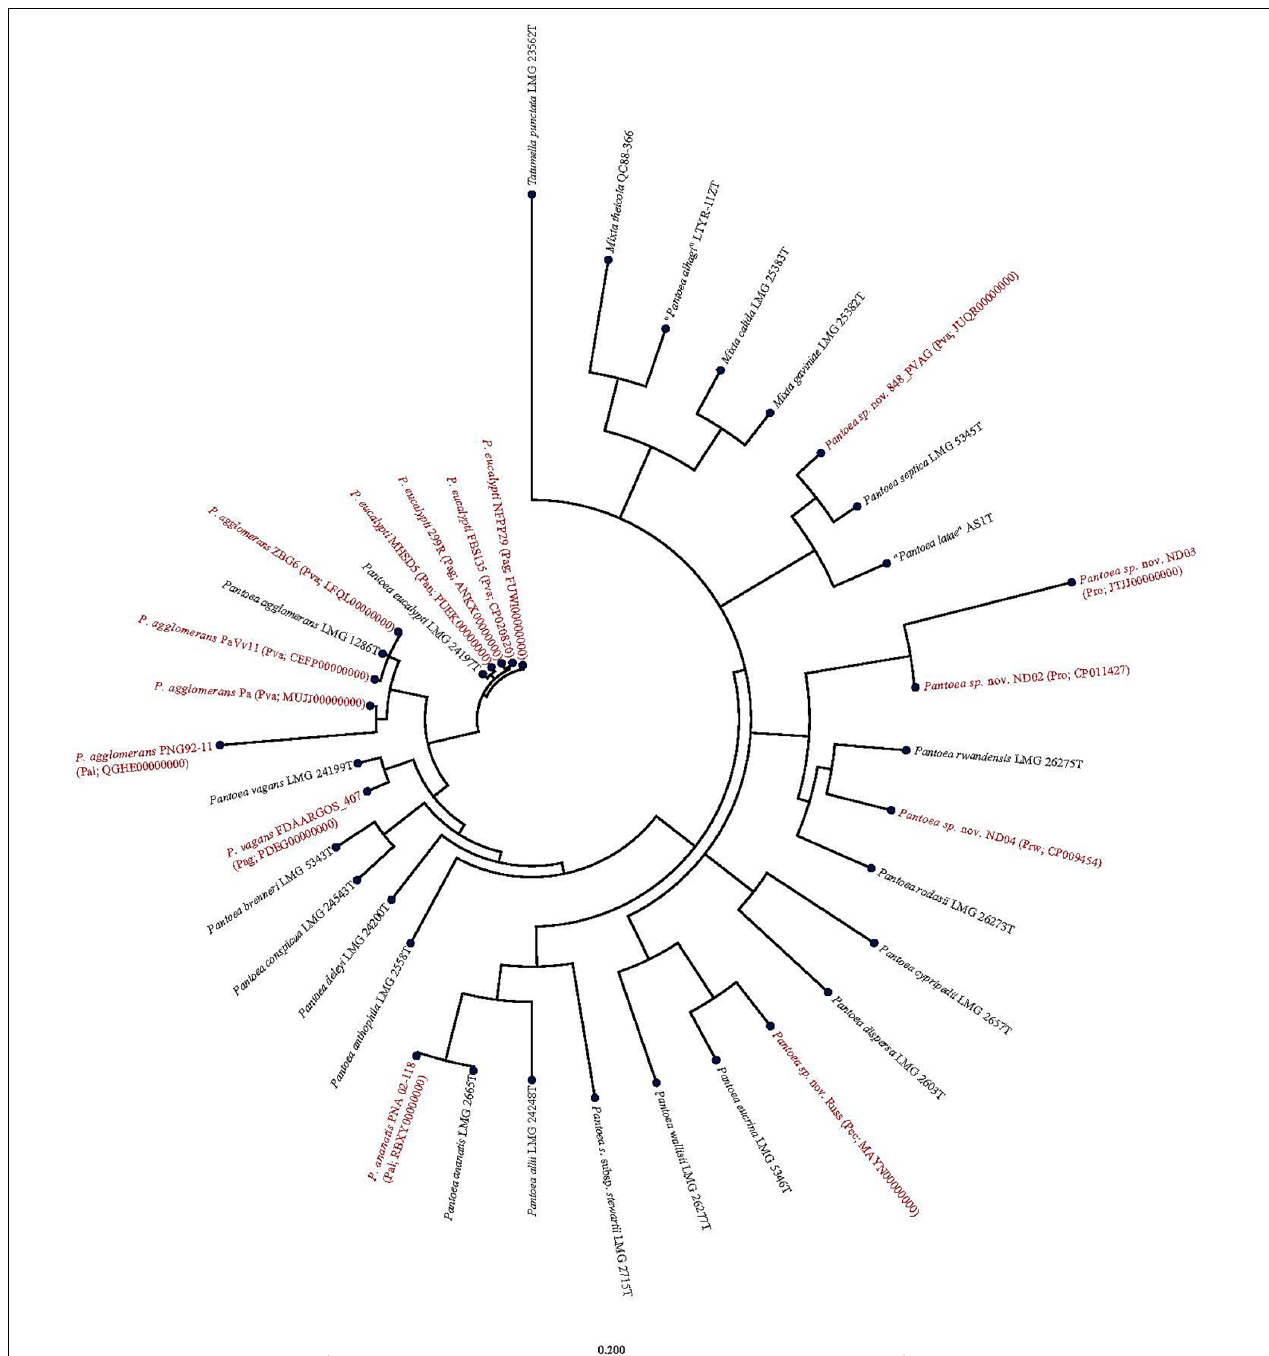
FIGURE 2 | Maximum likelihood phylogenetic analysis of complete and draft genomes (red) with incorrect species-level assignment relative to validly described type strains (black) of the genus Pantoea . For the incorrectly assigned genomes (red) in bracket: previous incorrectly assigned species (Pag, Pantoea agglomerans ; Pal, P. allii ; Pan, P. ananatis ; Pec, P. eucrina ; Pro, P. rodasii ; Prw, P. rwandensis ; and Pva, P. vagans ). Strains MR5, PaVv7, and PaVv9 were not included in the phylogenetic analysis because the draft genomes had short and fragmented fus A gene length sequence.